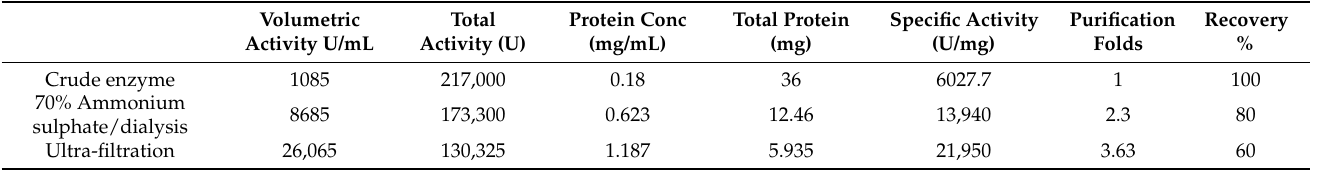
Table 9. Chart for the purification of inulinase